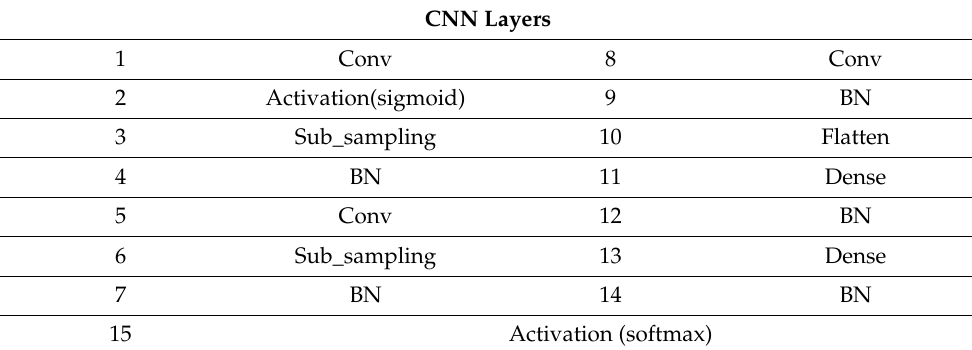
Table 3. The architecture of CNN for the